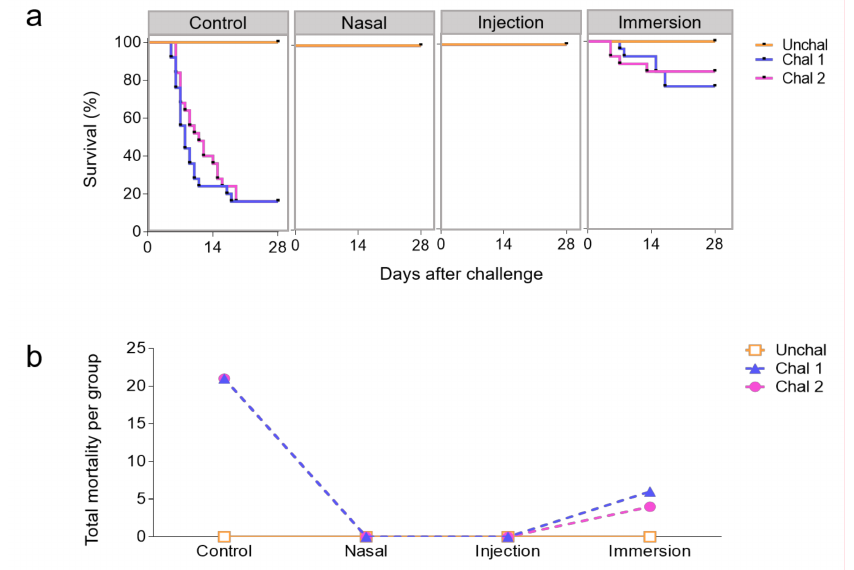
Figure 4. Protection conferred by live attenuated IHNV vaccine in trout. Survival curves ( a ) and total mortality ( b ) of trout vaccinated with live attenuated IHNV intranasally (IN), by intramuscular (i.m.) injection or by immersion (imm). Trout ( N = 25 per tank in duplicate tanks) were challenged to virulent IHNV i.p. 28 dpv (100 PFU). Unchal, unchallenged; Chal1 and Chal2 refer to duplicate tanks that were challenged for each experimental